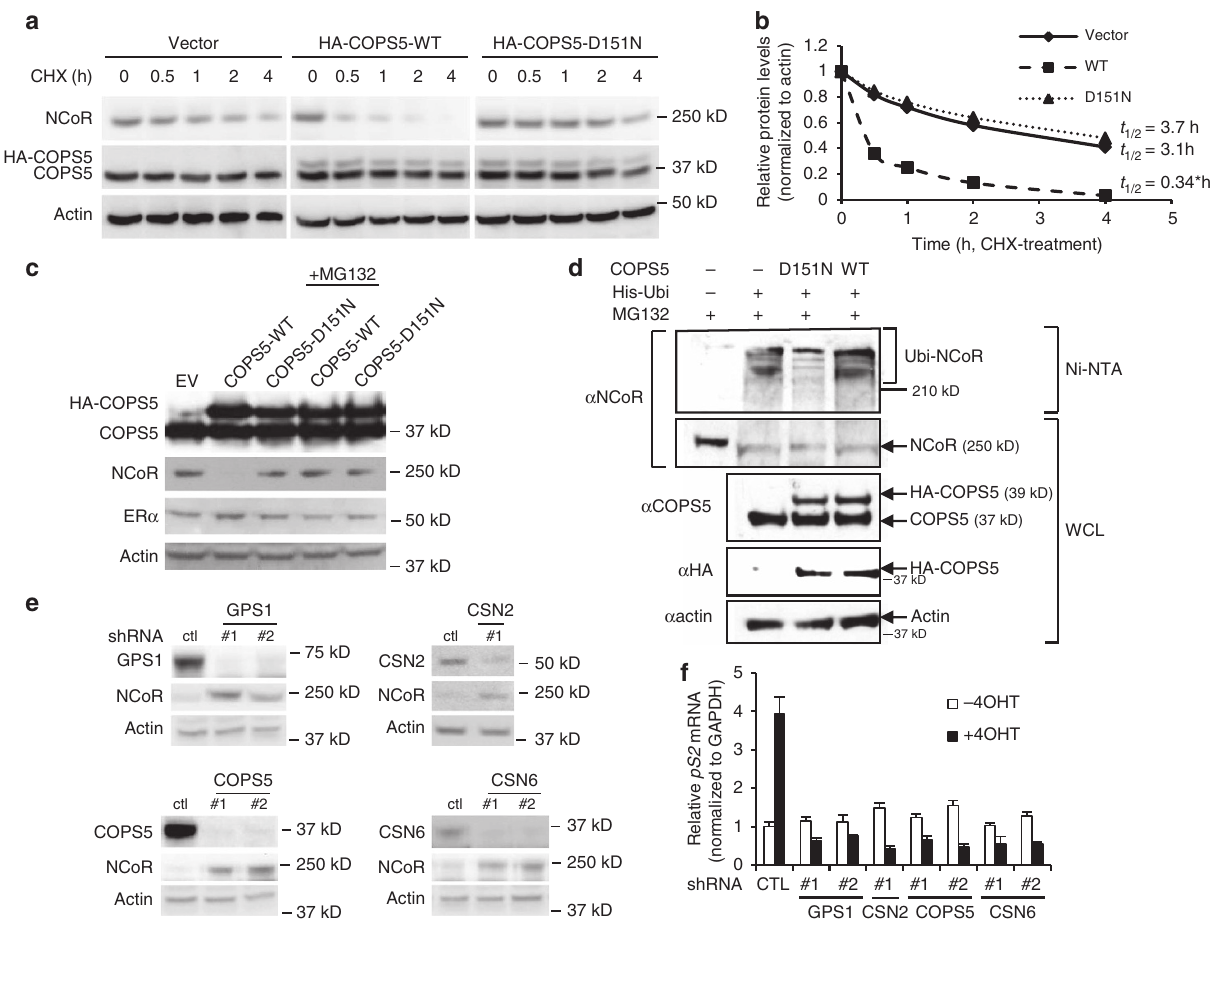
Figure 4 | COPS5 overexpression leads to degradation of NCoR protein through the ubiquitin–proteasome pathway. ( a ) Cycloheximide (CHX) chase assay in parental MCF7 cells transduced with vector, HA-COPS5-WT or HA-COPS5-D151N. Cells were treated with CHX and then analysed by western blotting. ( b ) Half-life of NCoR protein was calculated by quantification of the western blots of anti-NCoR and anti-actin (for normalization). *Significant difference compared with other samples ( P o 0.05, Student’s t -test). ( c ) Western blot analysis of COPS5, NCoR and ER a in MCF7 cells stably expressing empty vector (EV), WTor D151N COPS5 cDNA in the presence or absence of proteasome inhibitor MG132. ( d ) In vivo ubiquitination assay in HEK293Tcells with overexpression of WTor D151N COPS5. Proteins pulled down by Ni-NTA beads and existed in whole cell lysates (WCL) are tested by western blot using antibodies shown on the left. His-Ubi, His 6 -tagged ubiquitin; Ubi-NCoR, polyubiquitinated NCoR protein. ( e ) Western blot analysis of NCoR expression on knockdown of COP9 subunits GPS1, CSN2 and CSN6 by specific shRNAs in 4OHT-resistant MCF7 clone #3. Ctl, control. ( f ) Quantitative RT–PCR of mRNA of ER a target gene pS2 in the MCF7 cell lines shown in e in response to 4OHT (500nM) for 48h. Data are presented as mean þ s.e.m. of three biological replicates. All of the 4OHT-treated samples are significantly different from corresponding untreated samples ( P o 0.01, Student’s t